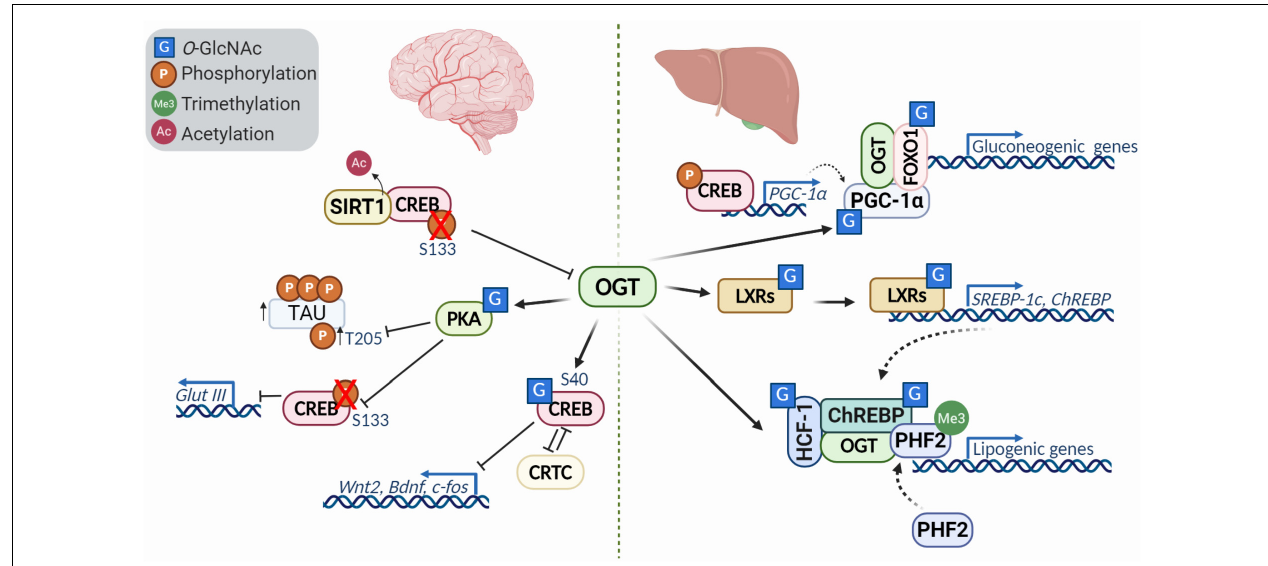
FIGURE 3 | Diversity of transcription factor O- GlcNAcylation in the brain and liver. O- GlcNacylation of transcription factors can act to modulate their activity, localization, stability, binding partners and other post translational modifications. In the brain (left) , O- GlcNAcylation of CREB represses its activity and downregulates transcriptional targets like Wnt2 and Bdnf in a CRTC (cAMP-regulated transcriptional co-activators)-dependent manner. Reduced O- GlcNAc of protein kinase A (PKA) is characteristic of Alzheimer’s disease, and leads to decreased phosphorylation of CREB at S133 and increased phosphorylation of tau at T205. Further, deacetylation of CREB by SIRT1, causes downregulation of OGT. In the liver (right) , modification of PGC-1a and association with OGT promotes FOXO1 O- GlcNAcylation, enhancing activity and promoting transcription gluconeogenic genes. The liver X receptors (LXRs) are nutrient sensors with critical roles in lipid metabolism, glucose homeostasis, and metabolism. O- GlcNAc modification of LXRs induces expression of SREBP-1 and ChREBP, key factors involved in hepatic lipogenesis and energy metabolism. HCF-1 O- GlcNAcylation stimulates OGT recruitment and modification of ChREBP, enhancing ChREBP activity and promoting recruitment of the activator PHF2 which binds the activating histone mark